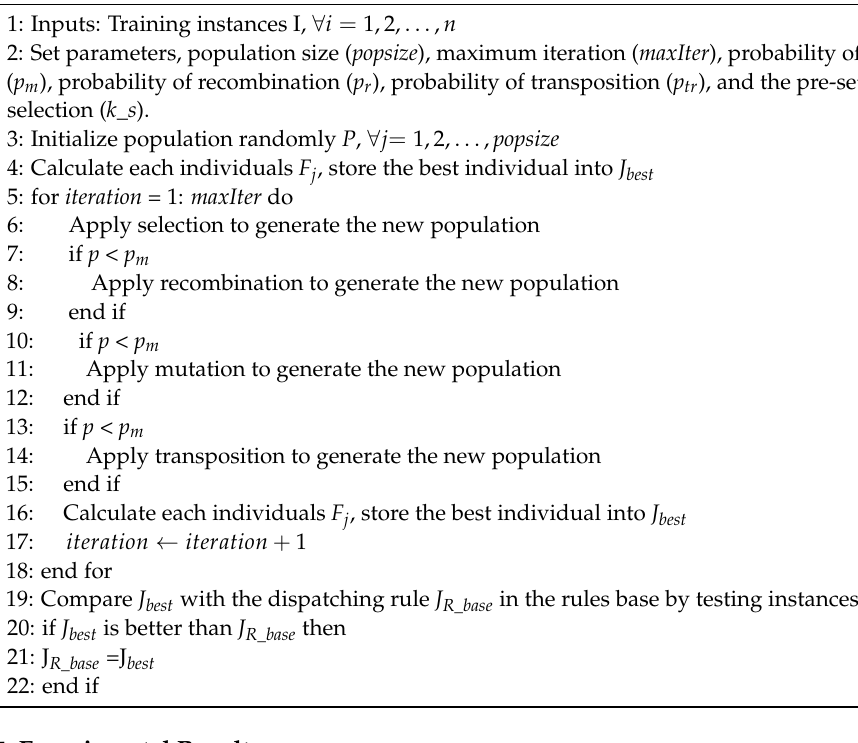
Algorithm 2. Overall framework of the IGEP-based offline training